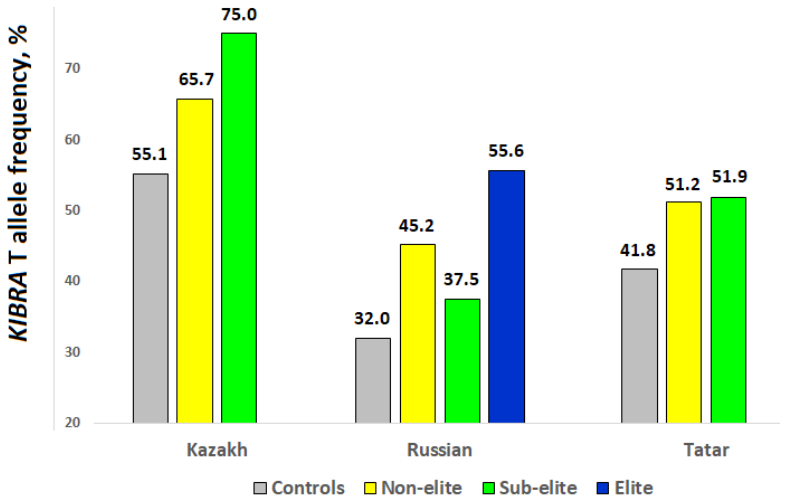
Figure 1. KIBRA gene rs17070145 T allele frequency in controls and chess players stratified by the level of achievement.